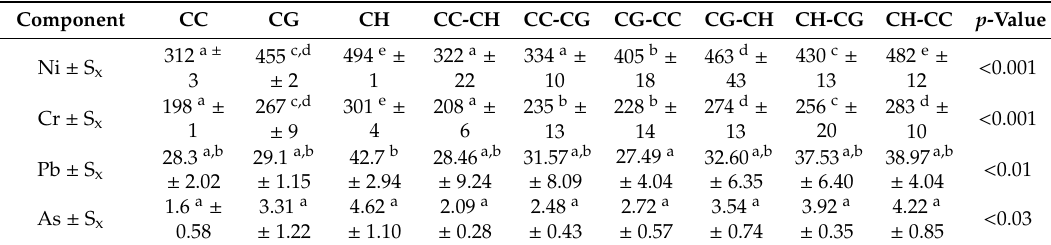
Table 5. Toxic elements content in ashes from the examined biomass (ppm).